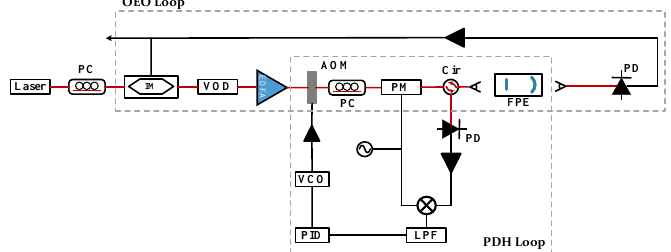
Figure 9. The schematic diagram of the OEO employing a WGM resonator. WGM: whispering gallery mode. PC: polarization controller. PD: photodetector. LNA: low noise amplifier. Reprinted with permission from Ref. [26], OSA, 2018.